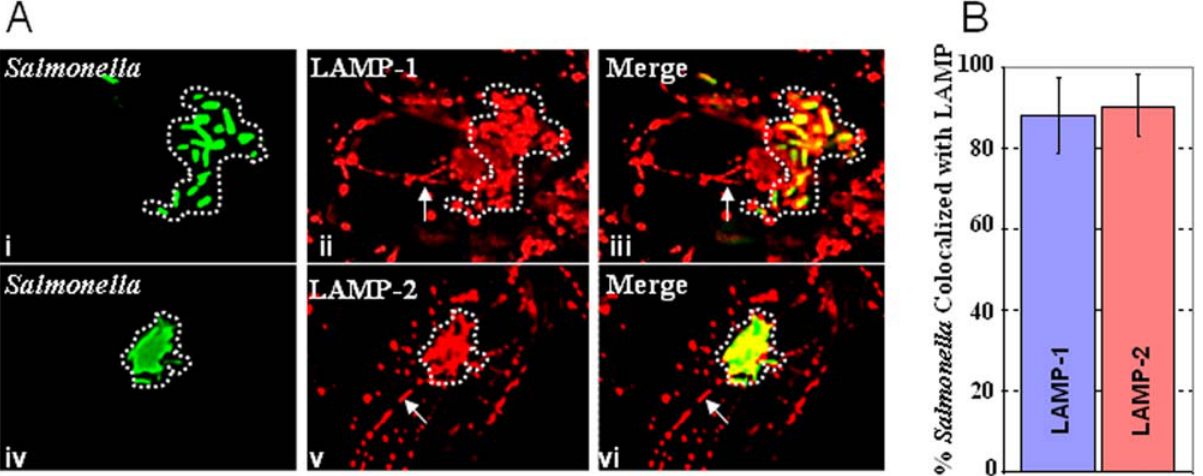
Figure 1. LAMP-2 localizes to the SCV and Sifs. A. HeLa cells were infected with wild type bacteria expressing GFP. 18 hours post-infection, the monolayers were fixed and immuno-stained to detect LAMP-1 (i–iii) or LAMP-2 (iv–vi). Green bacteria co-localized with LAMP-1 and LAMP-2, suggesting that both are recruited to the SCV (indicated by the dotted line). Sifs, which are marked by arrows, are also labeled by LAMP-1 and LAMP- 2. B. The extent of LAMP-2 labeling of the SCV is comparable to that seen for LAMP-1. Volocity image analysis software was used to quantitate the colocalization of GFP- Salmonella and LAMP-1 or LAMP-2. A two-tailed P value was obtained from the Volocity quantitation using the Student’s T test. The P value is=0.56 which indicates there is no significant difference between the colocalization of Salmonella with LAMP-1 or